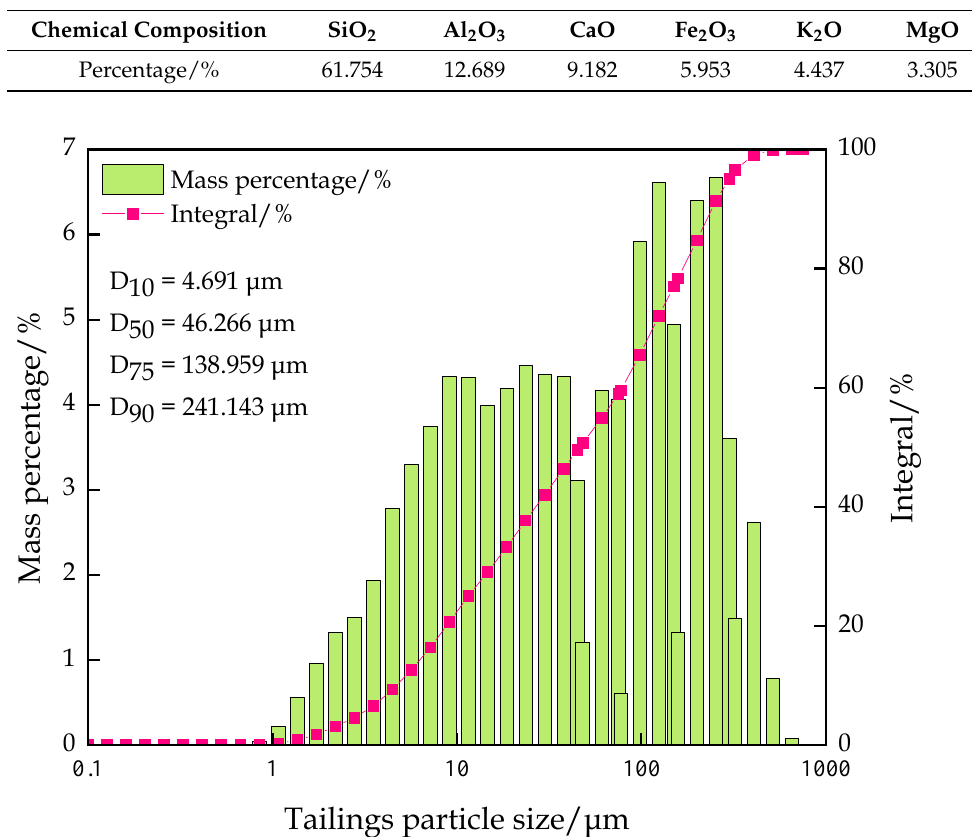
Table 2. Main chemical composition of classified fine tailings.